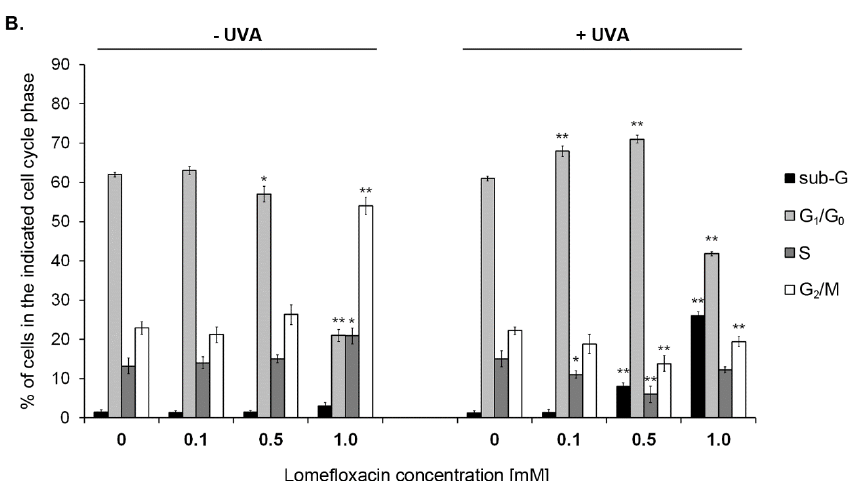
Figure 6. Changes in the cell cycle distribution of C32 ( A ) and COLO829 ( B ) melanoma cells after being cultured in the presence of lomefloxacin and UVA irradiation. Melanoma cells were pre-treated with lomefloxacin at concentrations of 0.1, 0.5, and 1.0 mM alone for 24 h or exposed to the drug and UVA irradiation (1.3 J/cm 2 ). The data are expressed as percentages of the controls. Mean values ± SEM from three independent experiments ( n = 9) performed in triplicate are presented. * p < 0.05, ** p < 0.005 vs. control samples. Representative histograms are available in the Supplementary Materials S4.